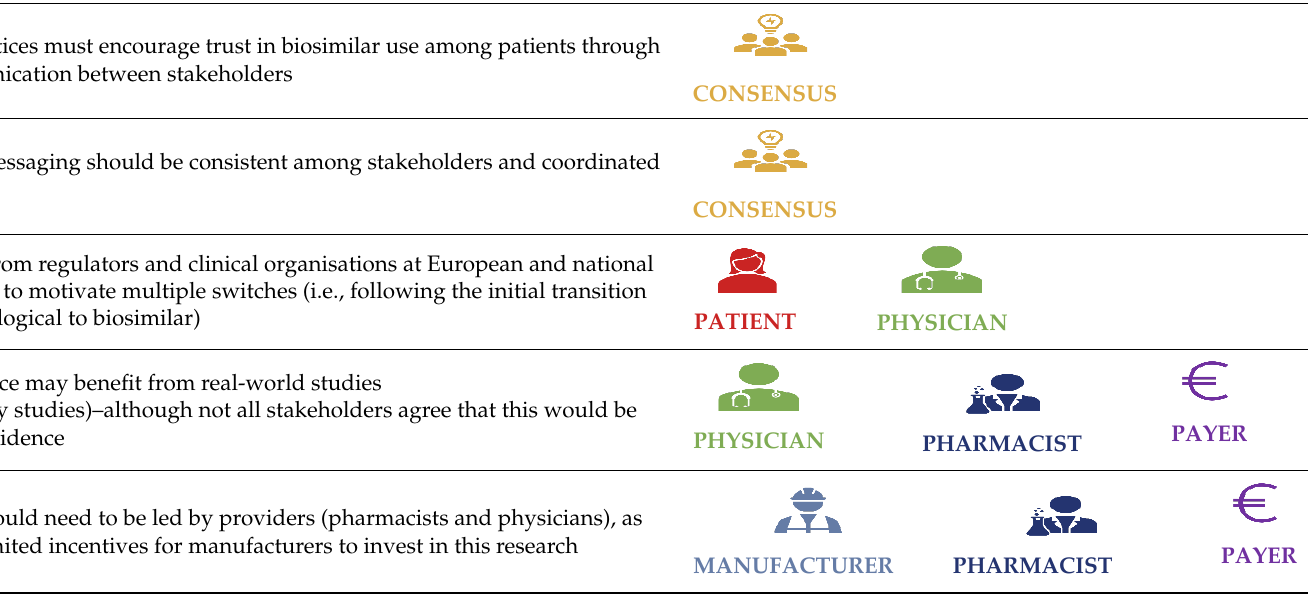
Table 1. Consensus on components of a sustainable biosimilar market.